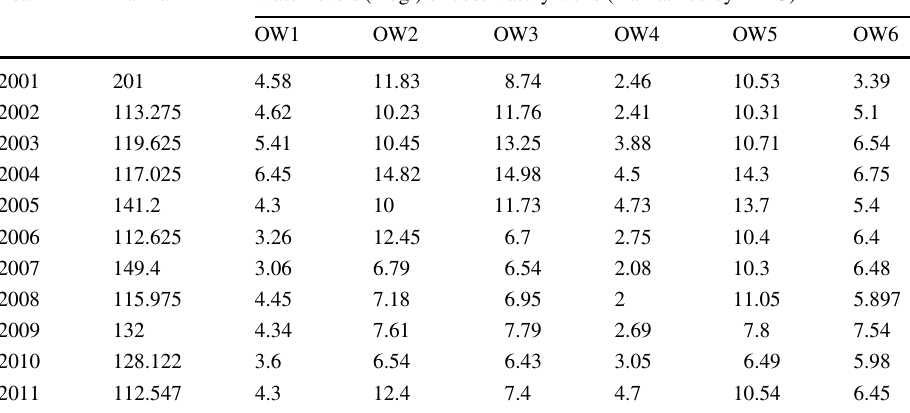
Table 6 Monsoon rainfall and water-table records